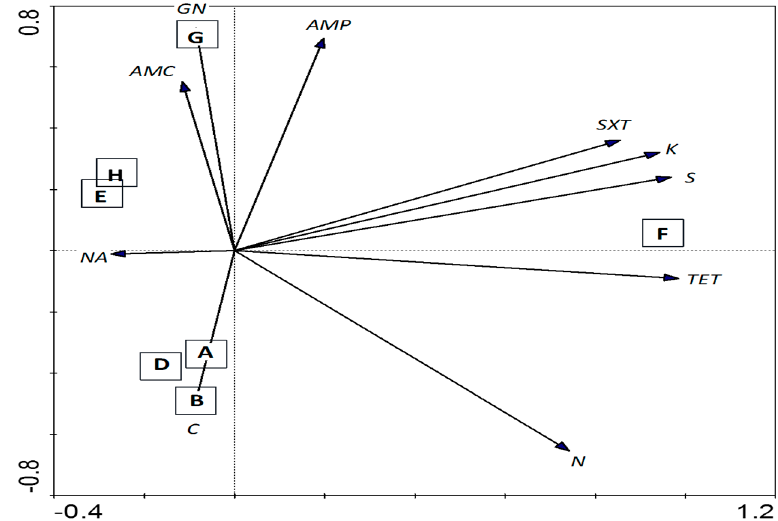
Figure 4. PCA ordination biplot showing the distribution of waterborne K. pneumoniae by sampling stations with respect to their susceptibility to various antibiotics. The first (PCA1) and second (PCA2) principal components respectively explained 74.2% and 17.3% of the total variance of the explanatory variables. The Capital letter in the square box denotes sampling stations located in Sepetang River ( A ), Sangga Besar River ( B – E ), Selinsing River ( G and H ) and adjacent coastal water ( F ). Black solid arrows indicate isolates demonstrating non-susceptibility towards 10 antibiotics: GN-NS, gentamicin; K-NS, kanamycin; S-NS, streptomycin; N-NS, neomycin; AMC-NS, amoxicillin/clavulanic acid; AMP-NS, ampicillin; NA-NS, nalidixic acid; TE-NS, tetracycline; SXT, sulfamethoxazole-trimethoprim; C, chloramphenicol.